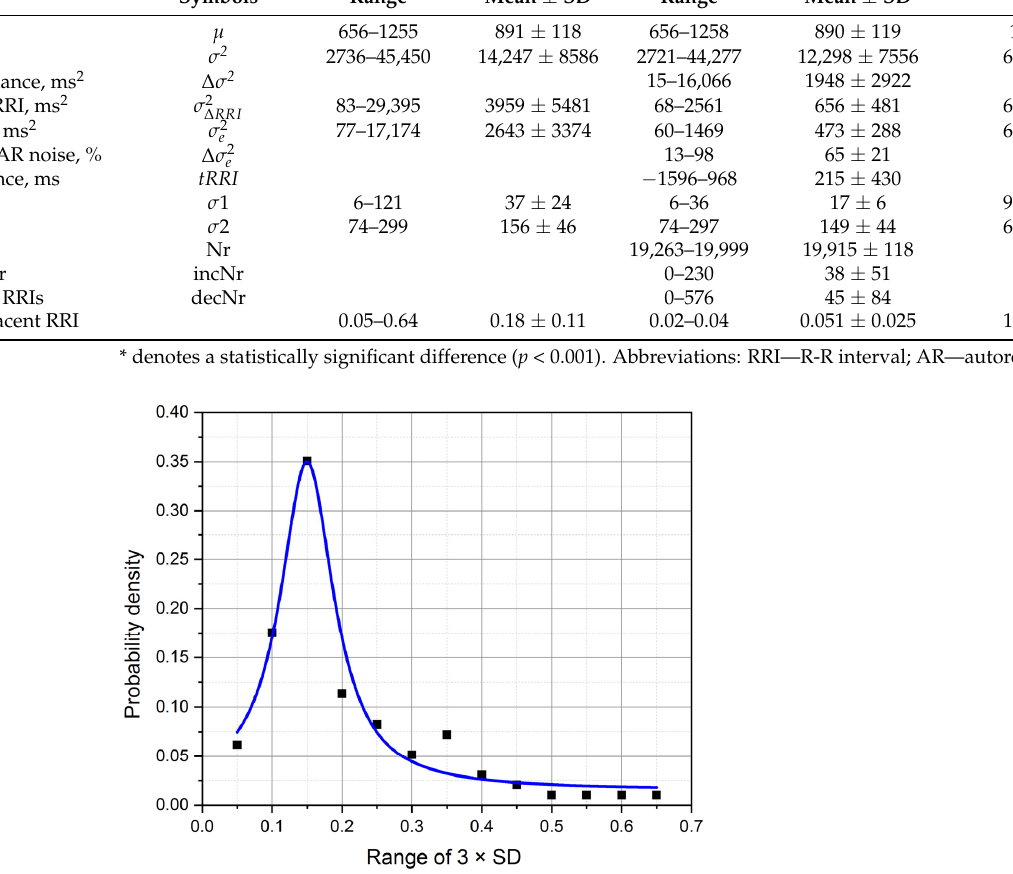
Figure 2. Distribution of averaged artifact standard deviation (3 × SD) of all 97 cases.